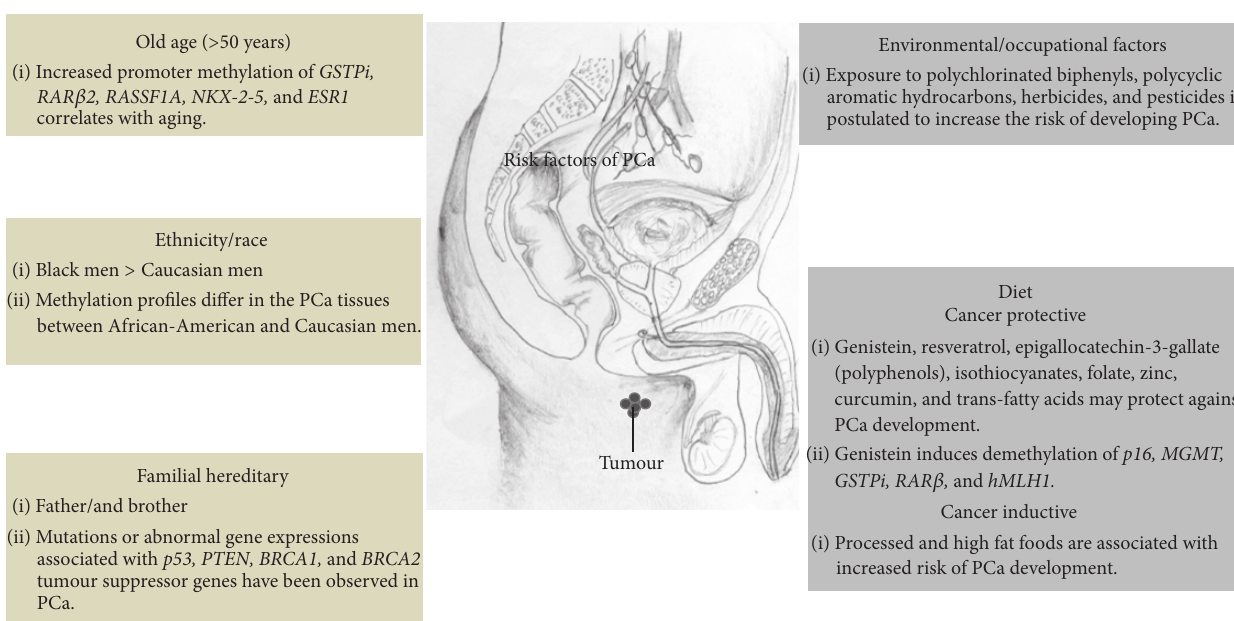
Figure 2: Risk factors associated with the development of prostate cancer. PCa risk factors can be categorised as nonmodifiable (e.g., old age, ethnicity/race, and familial hereditary) and modifiable (diet and environmental/occupational